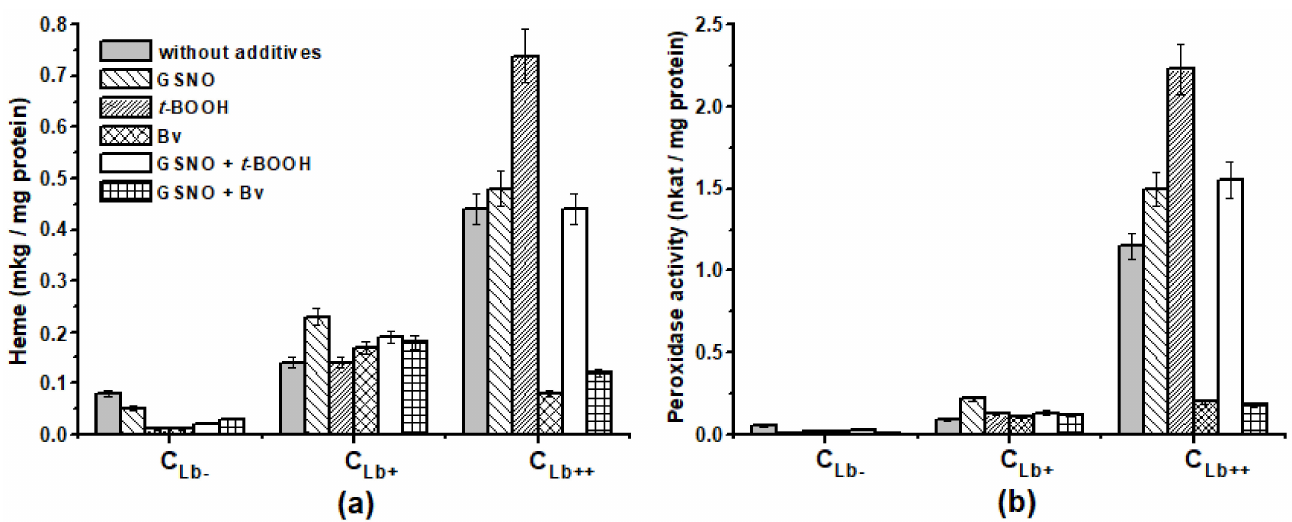
Figure 4. The concentration of heme—( a ), and the total peroxidase activity—( b ) of the cell lysate proteins in the middle of the logarithmic growth phase (4 h after the addition of the inducers of oxidative and nitrosative stress—7 h of